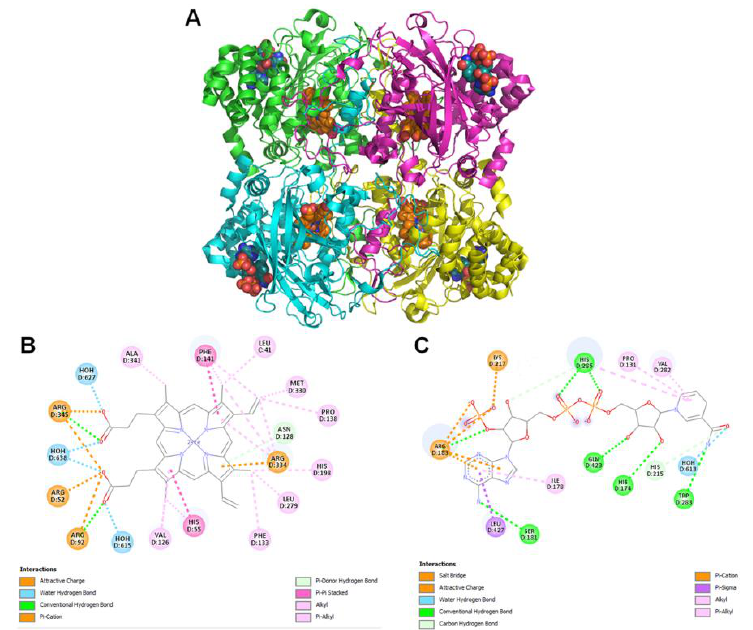
Figure 6. ( A ) Crystal structure of Pseudomonas aeruginosa catalase (KatA tetramer, PDB code: 4e37) complexed with heme and NADPH. All four chains are represented as cartoon with different colors and bound ligands presented as spheres (Heme carbons as blue and NADPH carbons as orange). ( B ) Heme and ( C ) NADPH interactions with KatA.